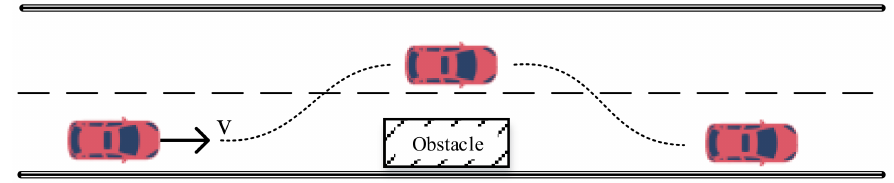
Figure 5. Double Lane Change